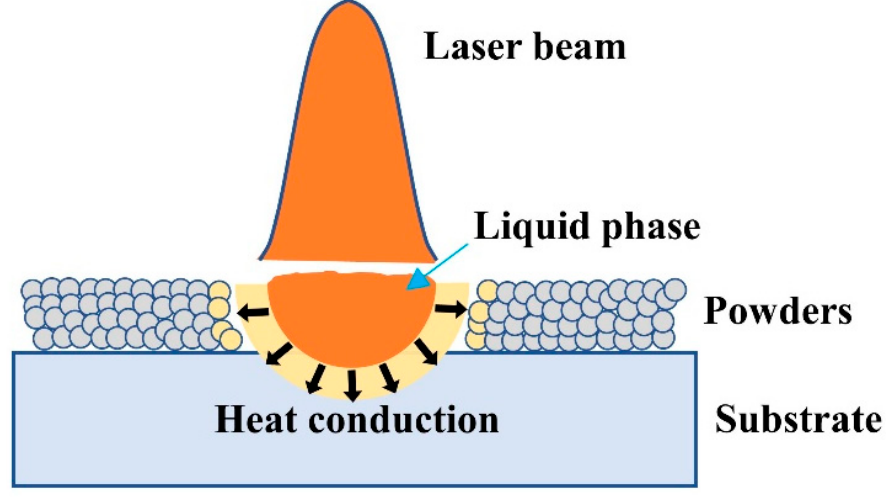
Figure 12. Schematic diagram of heat conduction during molten pool formation. As in previous studies, Fe, Ni, and Co belong to one family element, meaning a good wettability to the WC phase; thereby, Fe and Ni were also used as the binders of cemented carbide [33,34]. The contact angle of the single tracks formed on 316L substrates